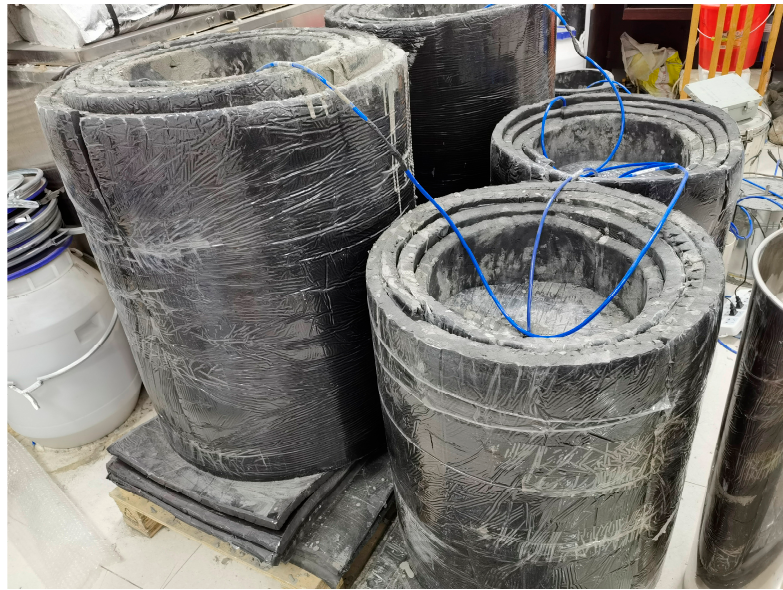
Figure 2. Schematic diagram of the simulation tool.